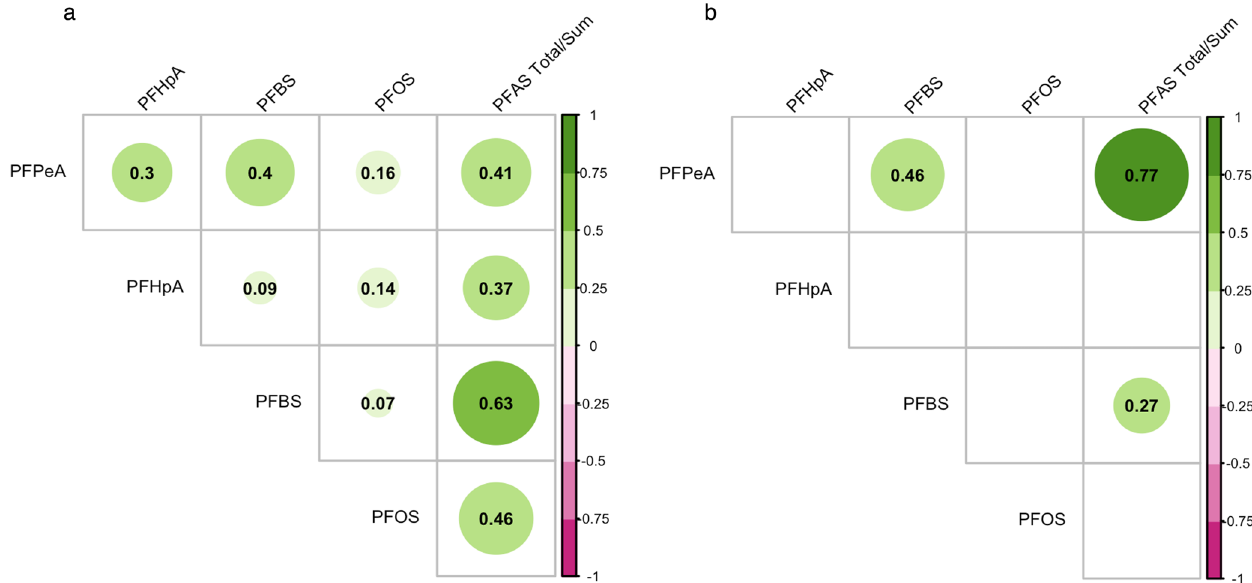
Fig. 3 Spearman correlation coef fi cients between PFAS measured in un fi ltered tap water. a First sampling (August – October 2020). b Second sampling (May 2021). Correlations were calculated for compounds detected in at least 45% of the samples. P value was <0.05 for all correlations shown.